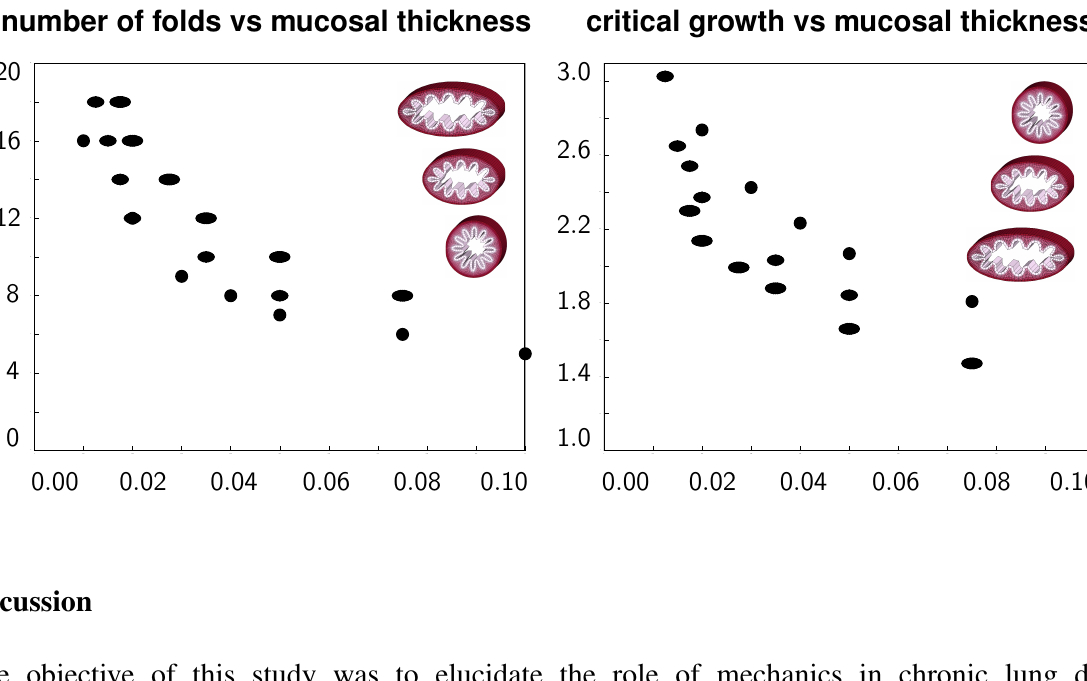
Figure 9. Failure Modes for Varying Cross Section